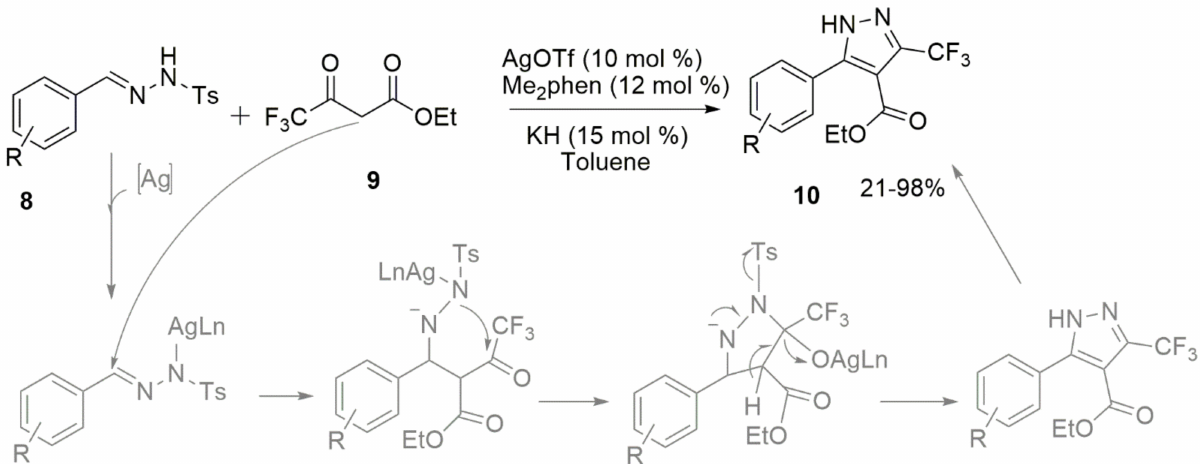
Scheme 3. Synthesis of 5-aryl-3-trifluoromethyl pyrazole derivatives in the presence of a silver catalyst